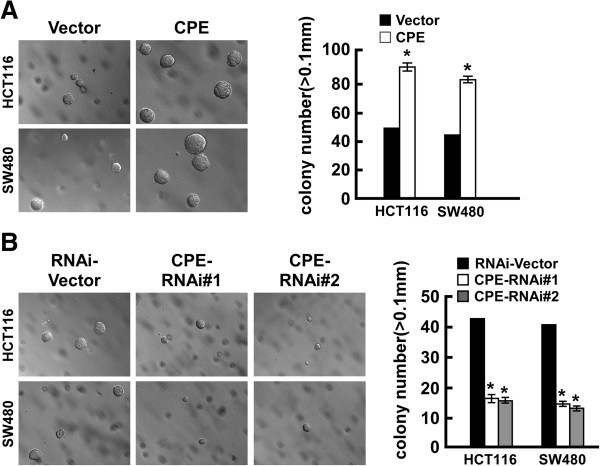
Overexpression/knockdown of CPE promotes/impairs tumorigenicity of colorectal cancer cells. (A) Representative micrographs (left panel) and quantification (right panel) of colonies formed in soft agar in CPE-overexpressing and vector cells. (B) Representative micrographs (left panel) and quantification (right panel) of colonies formed in soft agar in CPE-silencing and vector cells. Data are presented as mean ± SD from three independent experiments. *: P < 0.05.